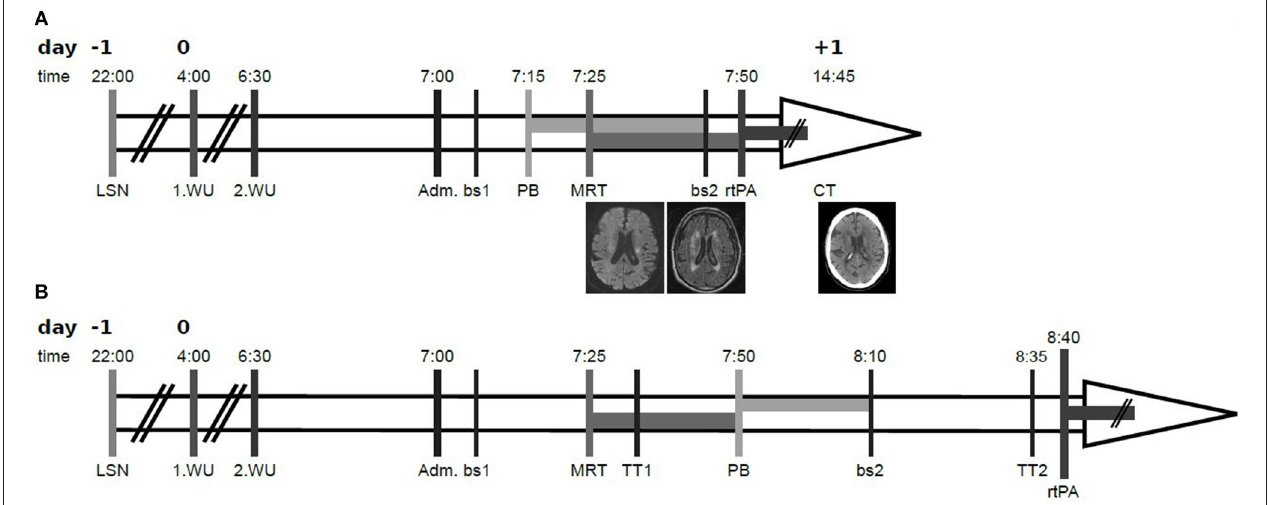
FIGURE 1 | Time course of the reported case. (A) shows the actual course, (B) shows the hypothetical course in case of awaiting laboratory and imaging results. All above the number of day is stated, relative to day 0 as admission day, followed by exact time in the second row. Time of last seen well (LSN) was reported for the eve of (day − 1. 22:00). First wake up (1.WU) with neurological deficit was reported for 4:00, second wake up (2.WU) for 6:30. The patient was admitted (Adm.) at 7:00 and clinically examined. In parallel a first blood sample was taken (bs1), followed by the administration of idarucizumab (PB), cerebral imaging (MRI), a second blood sample (bs2), and intravenous thrombolysis (rtPA). Analyses of the blood samples took 25–30min, so results for Thrombin time (TT1 and TT2, respectively) were available after this time. Exemplary slices of the diffusion weighted imaging (left) and fluid-attenuated inversion recovery (middle) sequences at admission as well as the control CT at day 1 (right) are shown in the last row of (A) . By comparing the actual starting point of intravenous thrombolysis (7:50) with the hypothetical one (8:40), where idarucizumab is applied after receiving the results of the first blood sample and after cerebral imaging, the reduction of the door-to-needle time is